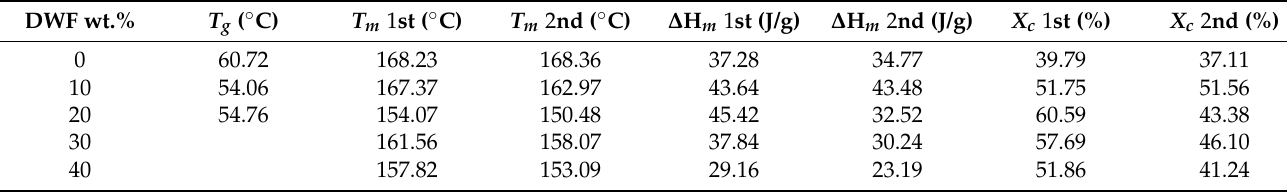
Table 2. Results of DSC analysis for the PLA-NaOH composite.